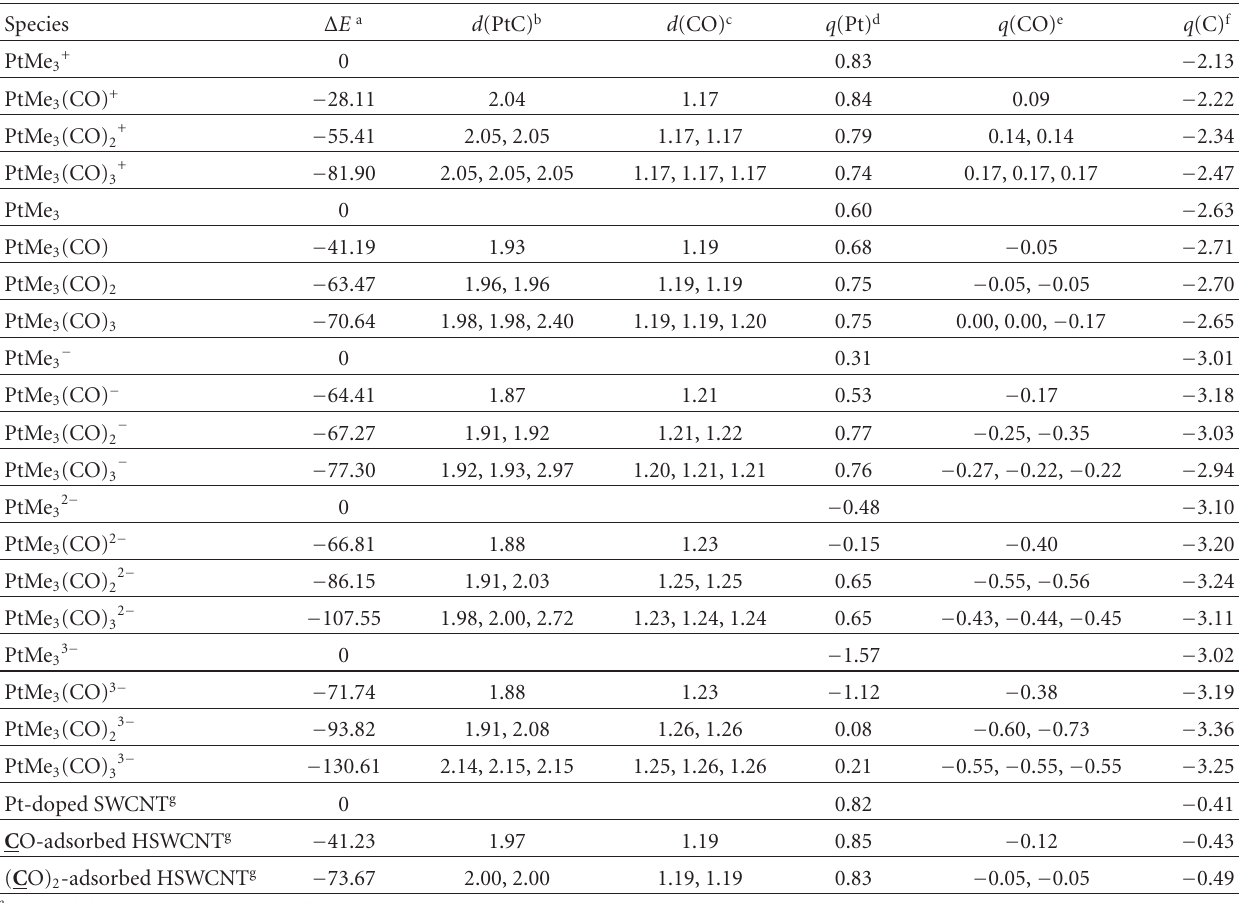
Table 4: Data for model alkylplatinum and nanotube-adsorbate complexes [114].